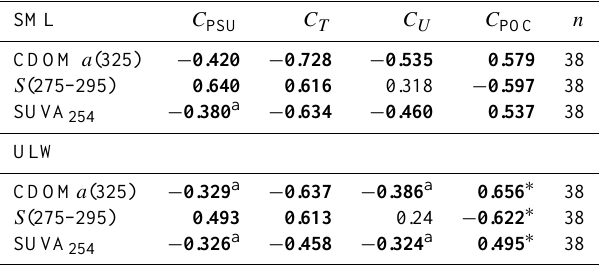
Table 5. Spearman rank order correlation ( C) between CDOM opti- cal properties both in the SML and ULW with salinity ( C PSU ) , wa- ter temperature ( C T ) , wind speed ( C U ) and particulate organic car- bon ( C POC ). Significant correlations ( p <0.01) are marked in bold (except a = p <0.05). n is the number of samples, except ∗ = 36 samples.